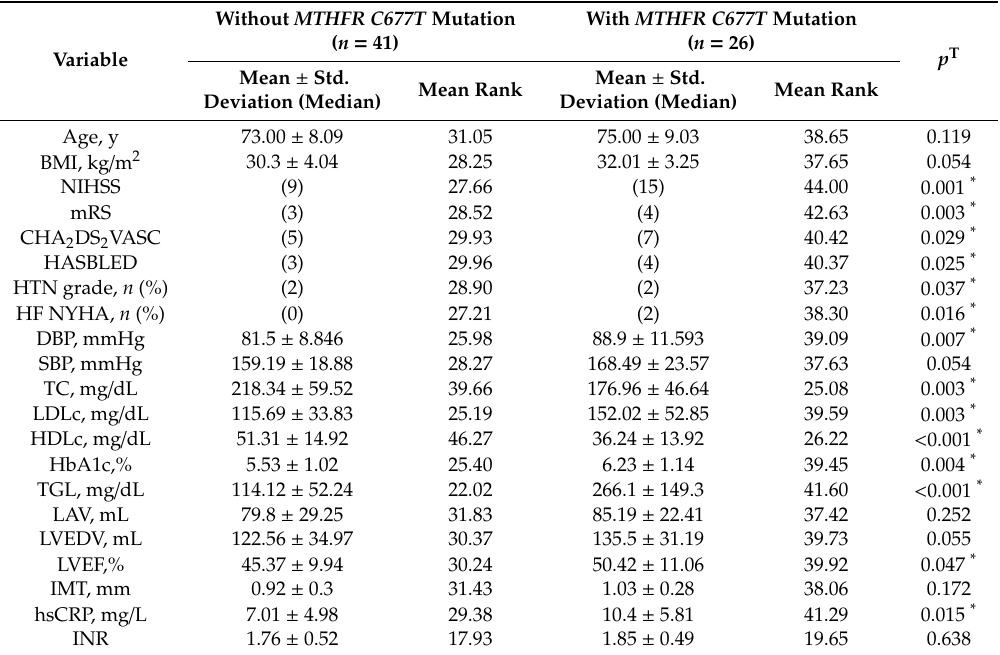
Table 1. Variable comparisons for MTHFR C677T mutation ( n = 67) in all patients using the Mann–Whitney U Test.